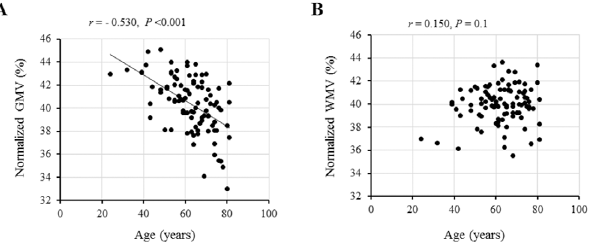
Fig 2. Correlations between age and normalized gray matter volume (GMV) and normalized white matter volume (WMV). A significant inverse correlation is found between age and normalized GMV (A), while no correlation is found between age and normalized WMV (B).